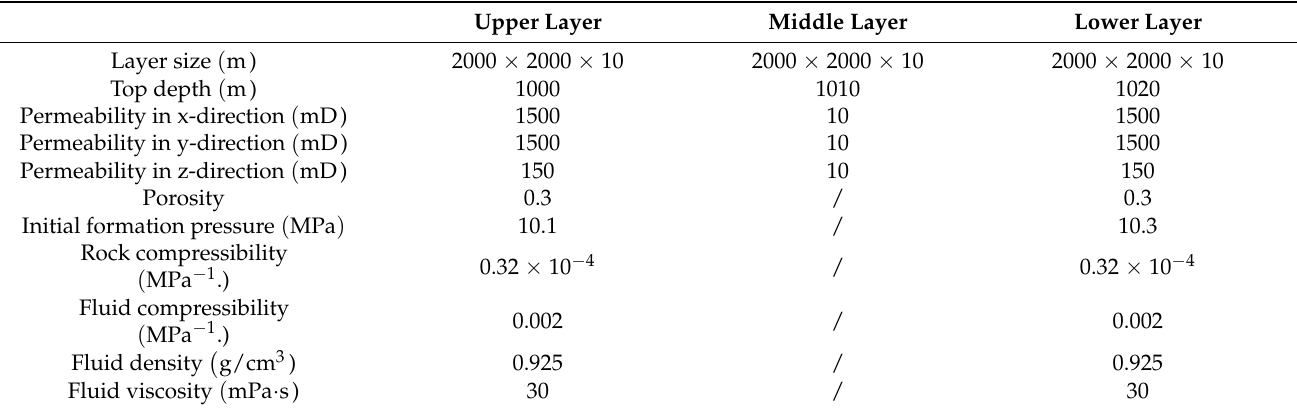
Table 8. The basic data of reservoir.